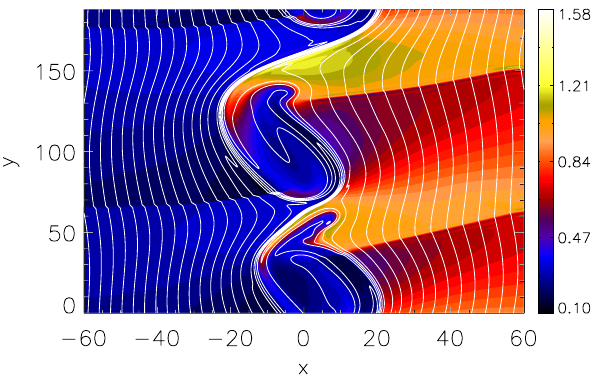
Fig. 3. Shaded isocontours of the absolute value of the velocity component in the (x,y)-plane at t = 160, V 0 = 6.